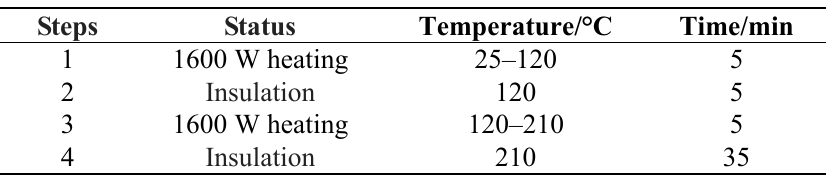
Table 1. Ultrawave digestion procedure.